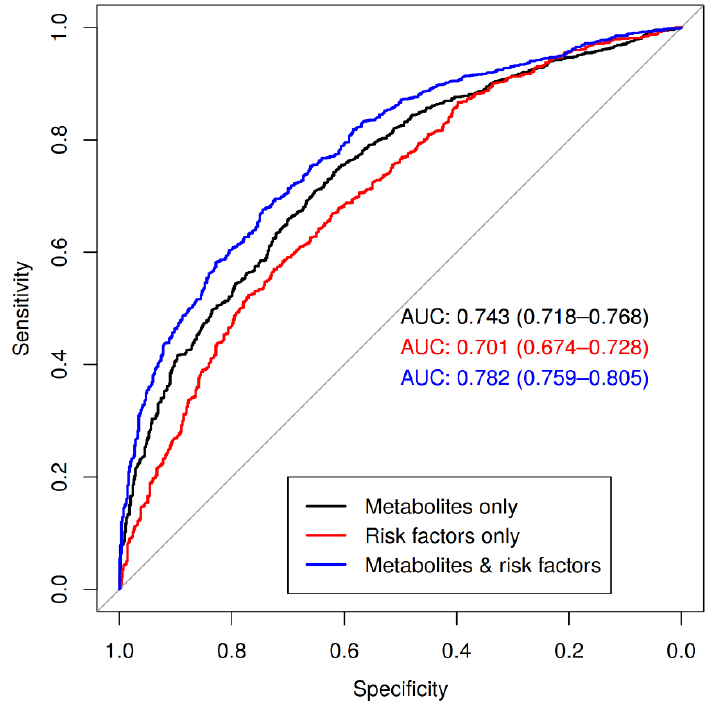
Figure 3. Performance of metabolites and/or risk factors to predict CAD. We present receiver-operating-characteristic (ROC) and respective areas under the ROC curve (AUC) with corresponding 95% confidence intervals. Black: model including only metabolites as predictors; red: model of nine risk factors; blue: model including all risk factors and metabolites as predictors. While the risk factors-only model performs worst, the combined model shows an increase in predictive ability over its competitors ( p = 3.1 × 10 − 18 for combined vs. risk factors-only, p = 1.5 × 10 − 4 for combined vs. metabolites-only, one-sided Delong test). The difference between metabolites-only vs. risk factors-only is also significant ( p = 0.01795, two-sided Delong test).